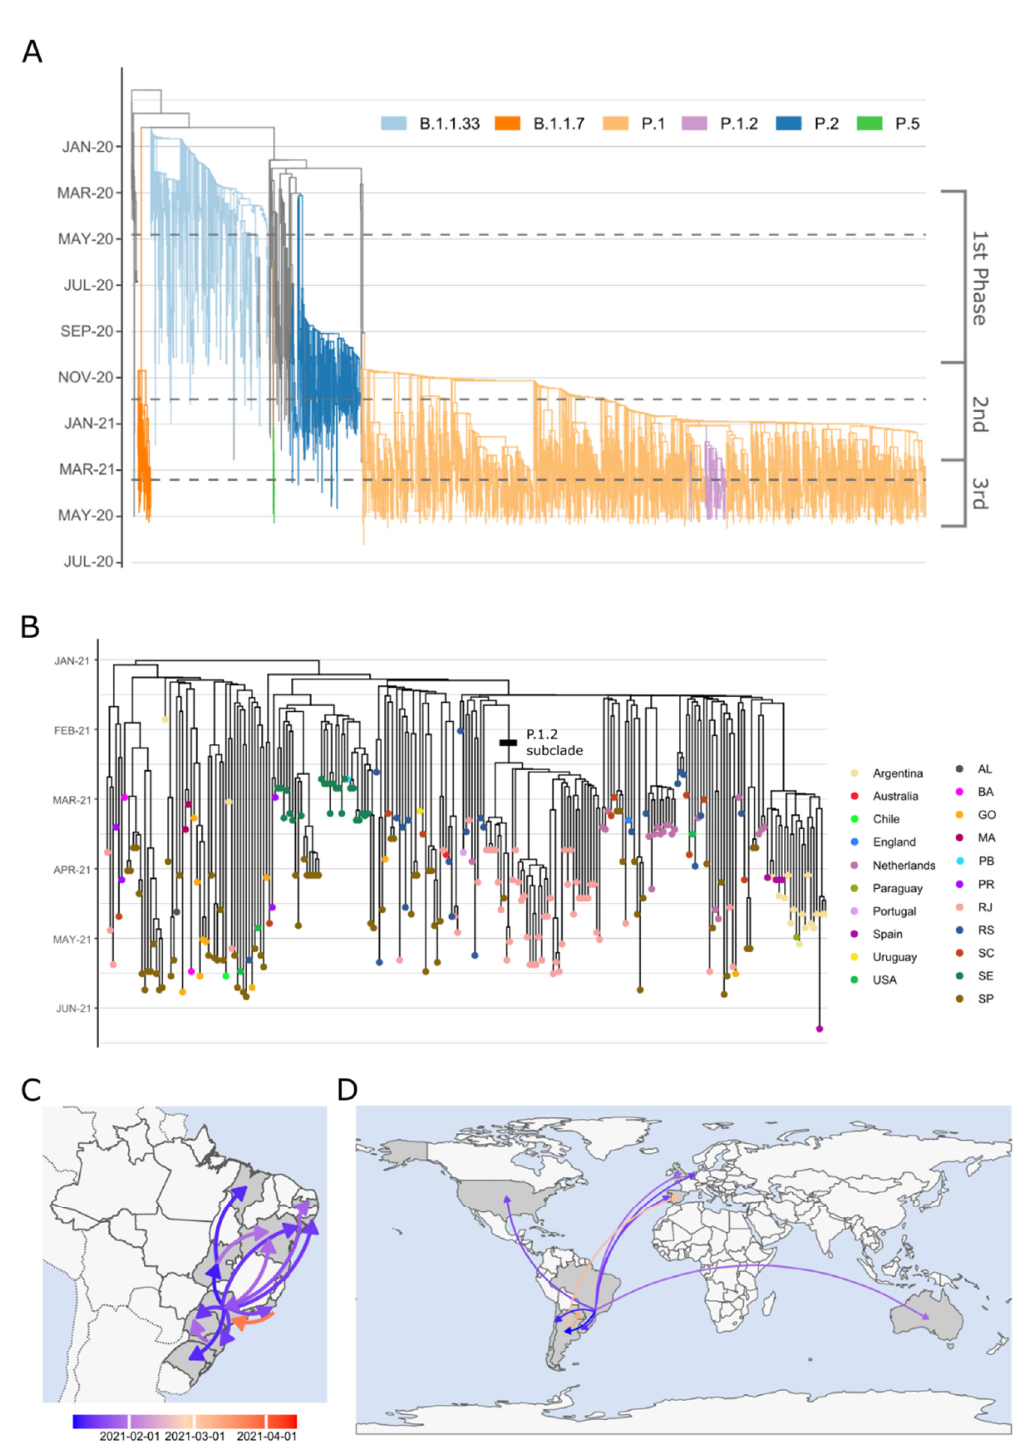
Figure 3. Evolutionary relationships between major lineages present in Rio de Janeiro and the evolution and dispersal of the new lineage P.1.2. ( A ) Time tree of 3029 genomes from the state of Rio de Janeiro, with lineages of interest highlighted by branch color. ( B ) Divergence dates between P.1.2 sequences indicate that the lineage originated at the first days of 2021. Black bar signals the subclade with A262S mutation in Spike. Colored dots show the location of sampling. ( C , D ) National and international transmission routes inferred for the dispersion of P.1.2. The color of the arrows corresponds to the date of the first dispersal event between locations.